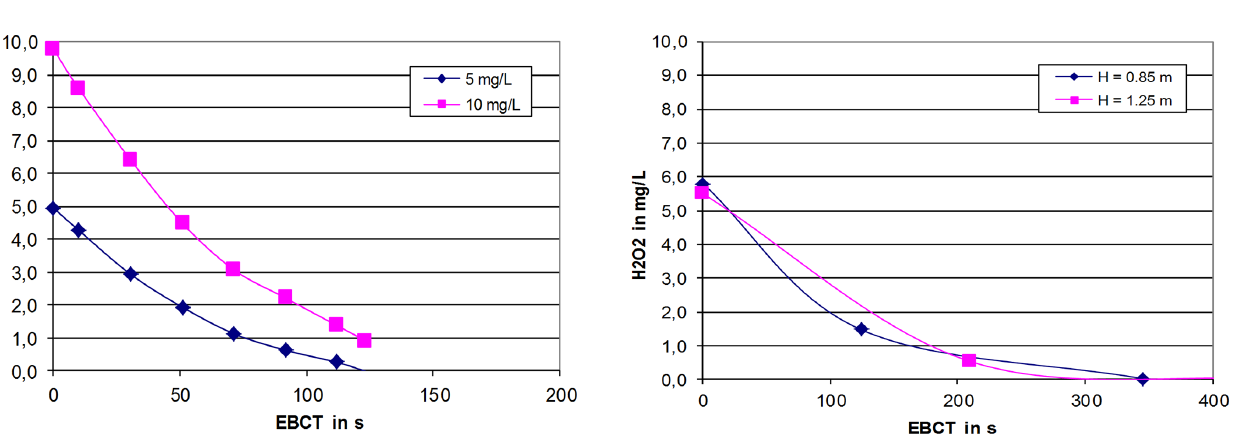
Figure 1. Decomposition of hydrogen peroxide with ROW 0.8 cat in R20 (bed height 1.4m, flow rate 40mh − 1 , water temperature 1.8 ◦ C).